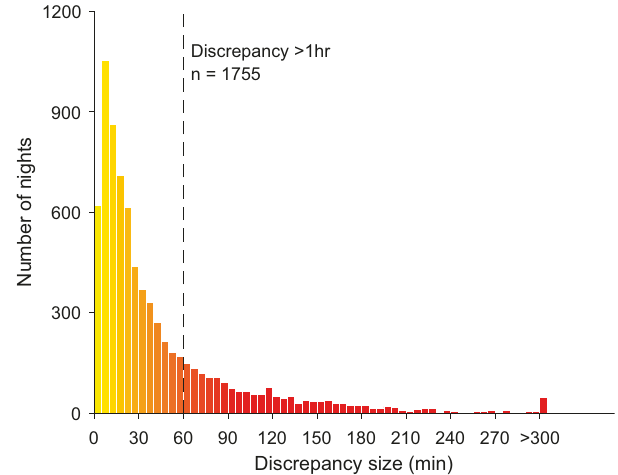
Fig. 5 Histogram depicting the occurrence of discrepancies of a given magnitude (in minutes). For each night, the highest discrepancy among all three modalities was used. The dashed line indicates the discrepancy threshold of 1 h used in the